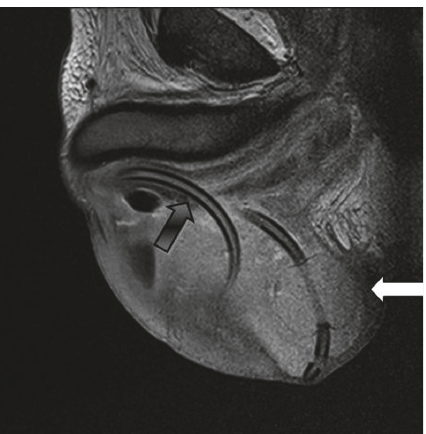
Figure 1: Scrotal MRI (sagittal): urethroscrotal fistula (black arrow) with catheter rolled in the scrotal sac, balloon (white arrow).